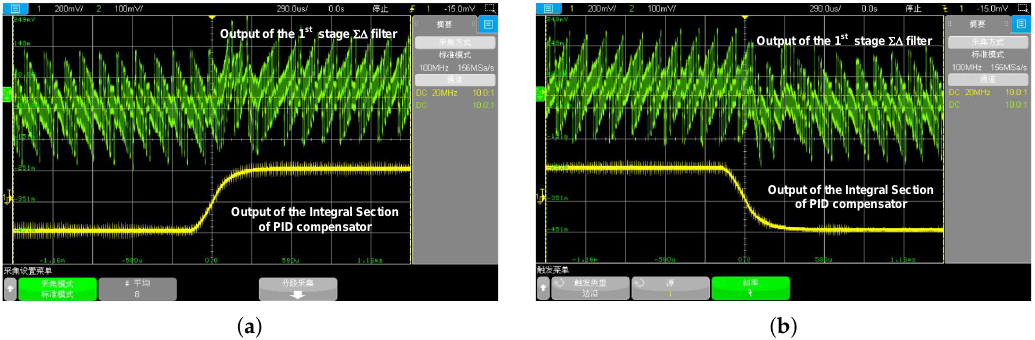
Figure 16. The step response of the EM- Σ∆ system: ( a ) the step response of rising edge; ( b ) the step response of the falling edge.